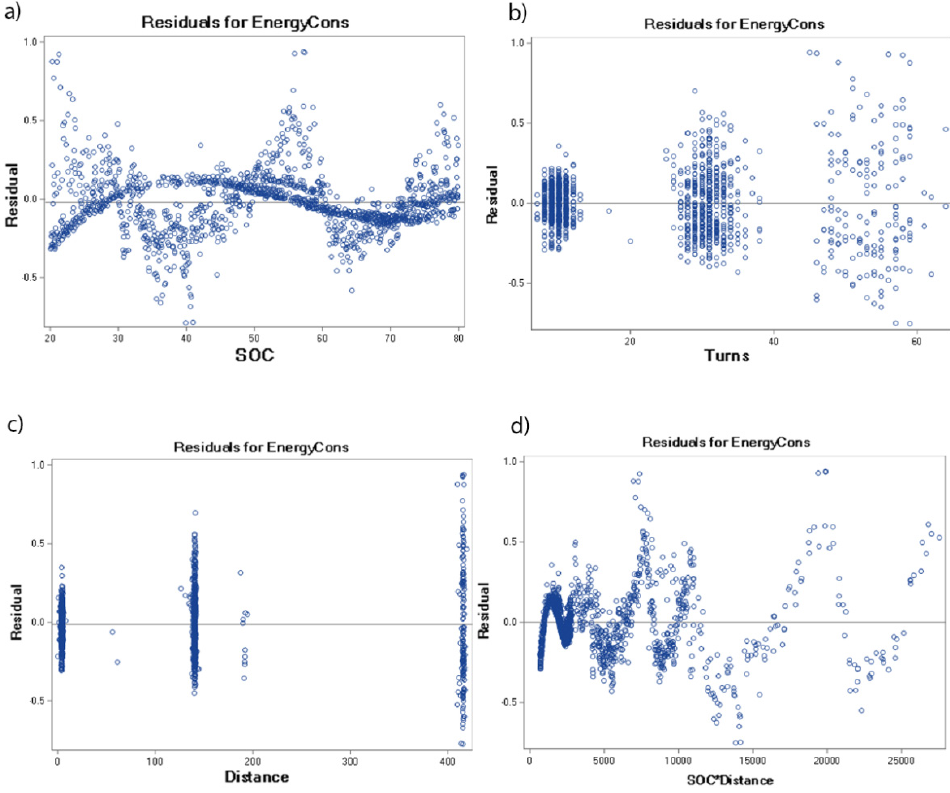
Figure 6. Residuals for selected effects of the tested battery from 2018.